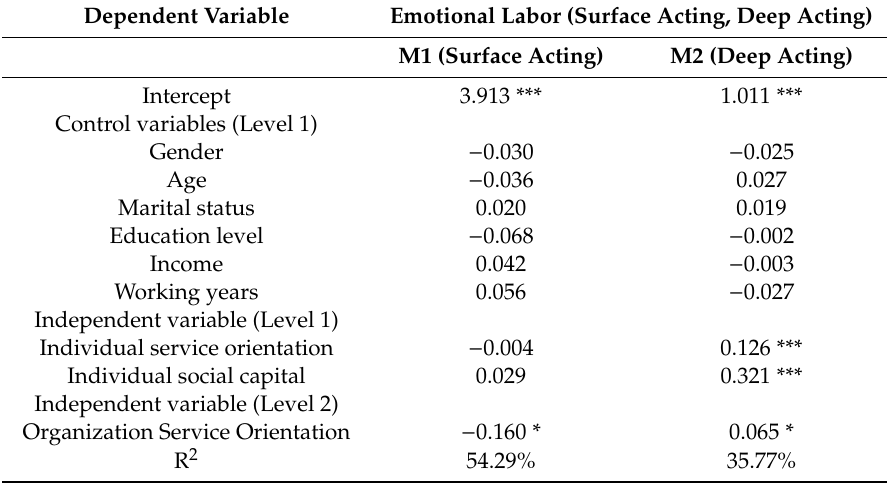
Table 9. The mediating role of individual social capital (the fourth condition test).